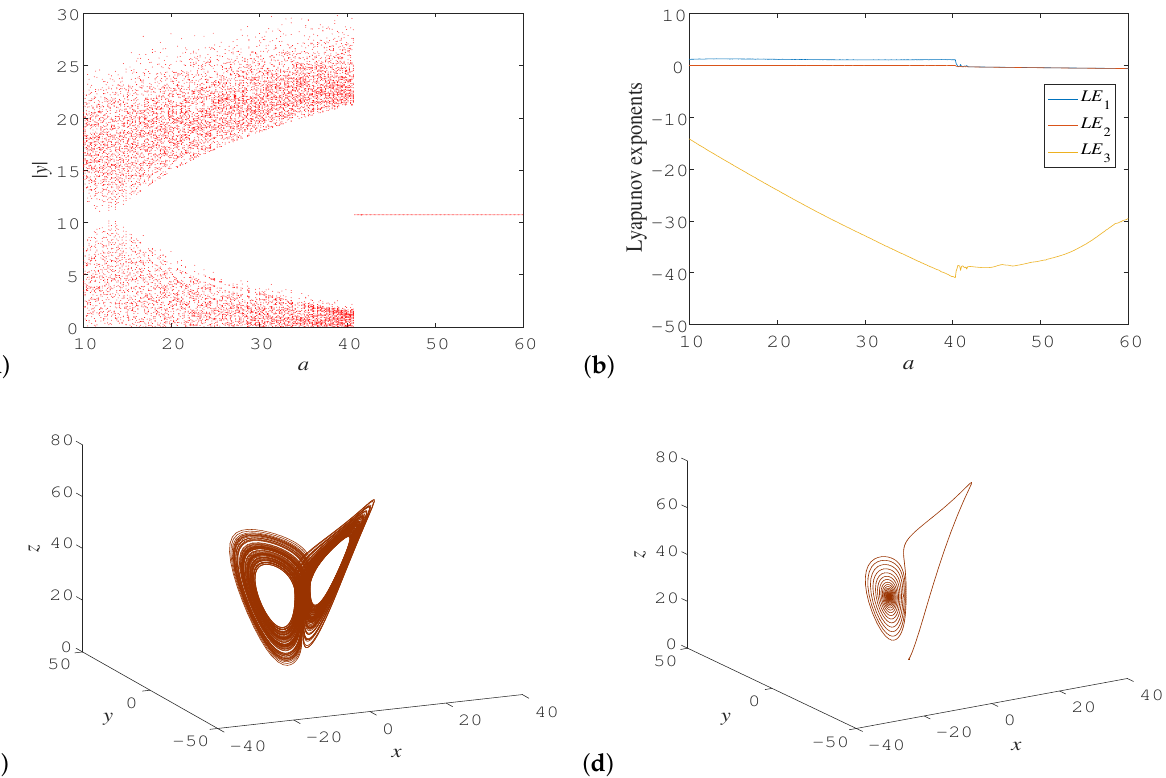
Figure 2. ( a ) Bifurcation diagram and ( b ) Lyapunov exponents spectrum of system (2) vs. a , where b = 3, c = 35, and d = 10. 3D view of phase portraits with ( c ) a = 30 and ( d ) a = 50. Taking the parameter b ∈ [ 0, 5 ] , and letting a = c = 35 and d = 10, the bifurcation diagram and corresponding Lyapunov exponents spectrum are depicted in Figure 3. It is found that the system changes from periodic to chaotic through period-doubling bifurca- tions, and eventually becomes a stable state, indicating that the system has complicated dynamical characteristics. We note that diverse periodic attractors of the system appear with different parameters b , as shown in Figure 4.